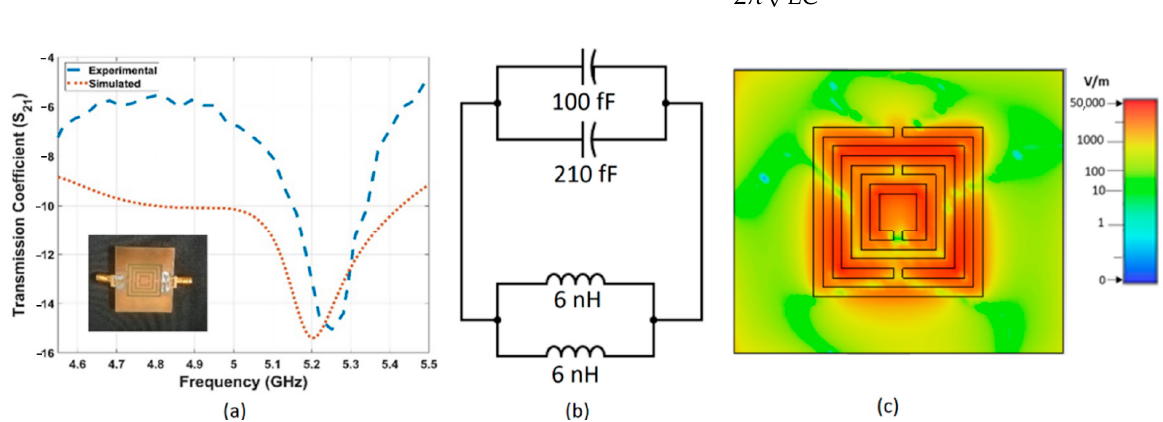
Figure 2. ( a ) Simulated and experimental values of transmission coefficient (S 21 ) at different frequencies. ( b ) Equivalent LC model of the CSRR sensor. ( c ) Electric field profile at the resonance frequency.